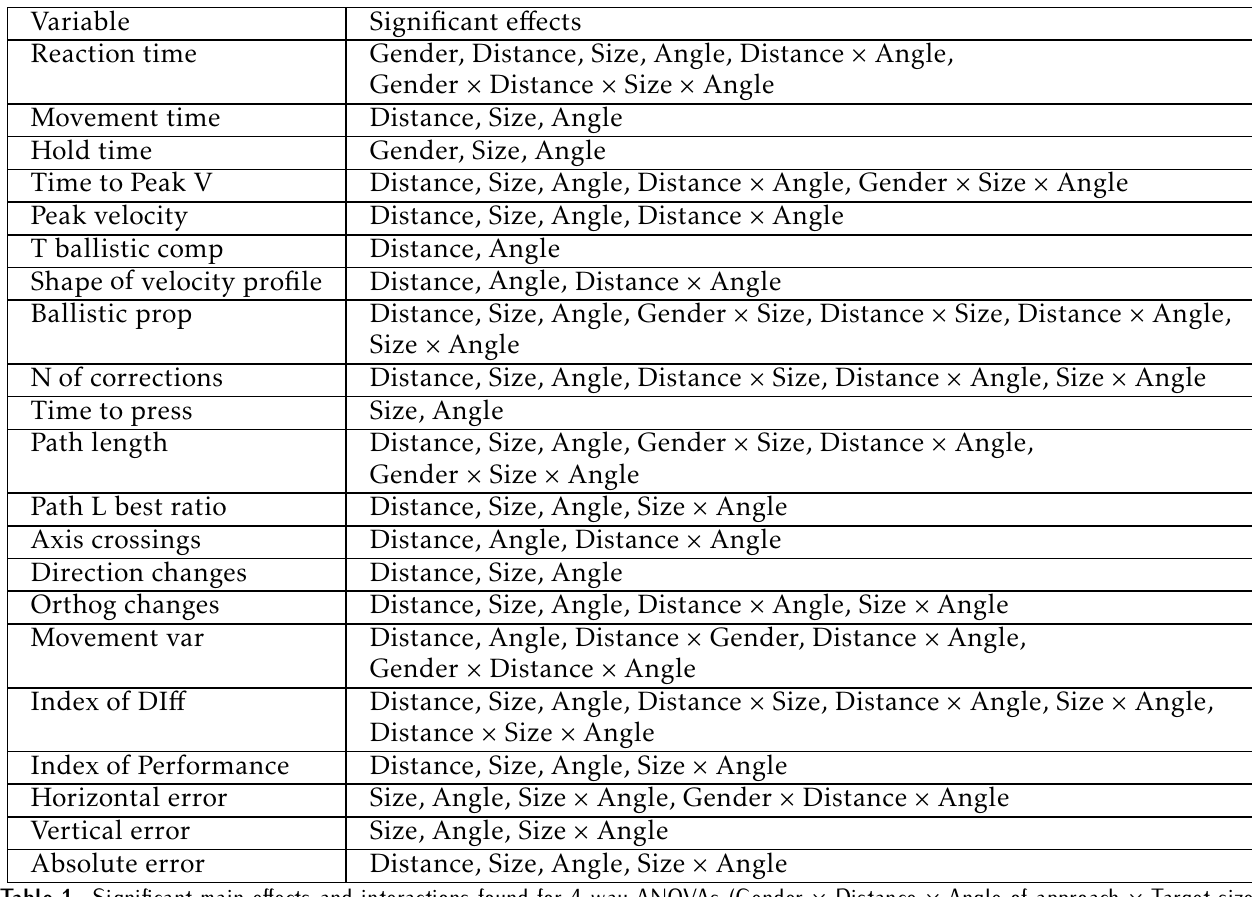
Table 1. Significant main effects and interactions found for 4-way ANOVAs (Gender × Distance × Angle of approach × Target size) conducted for each